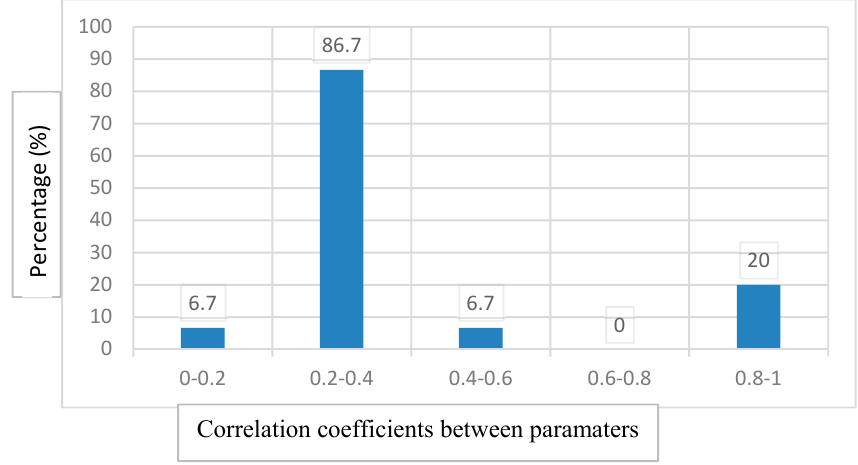
Figure 5. Percentage of correlation coefficients between paramaters.